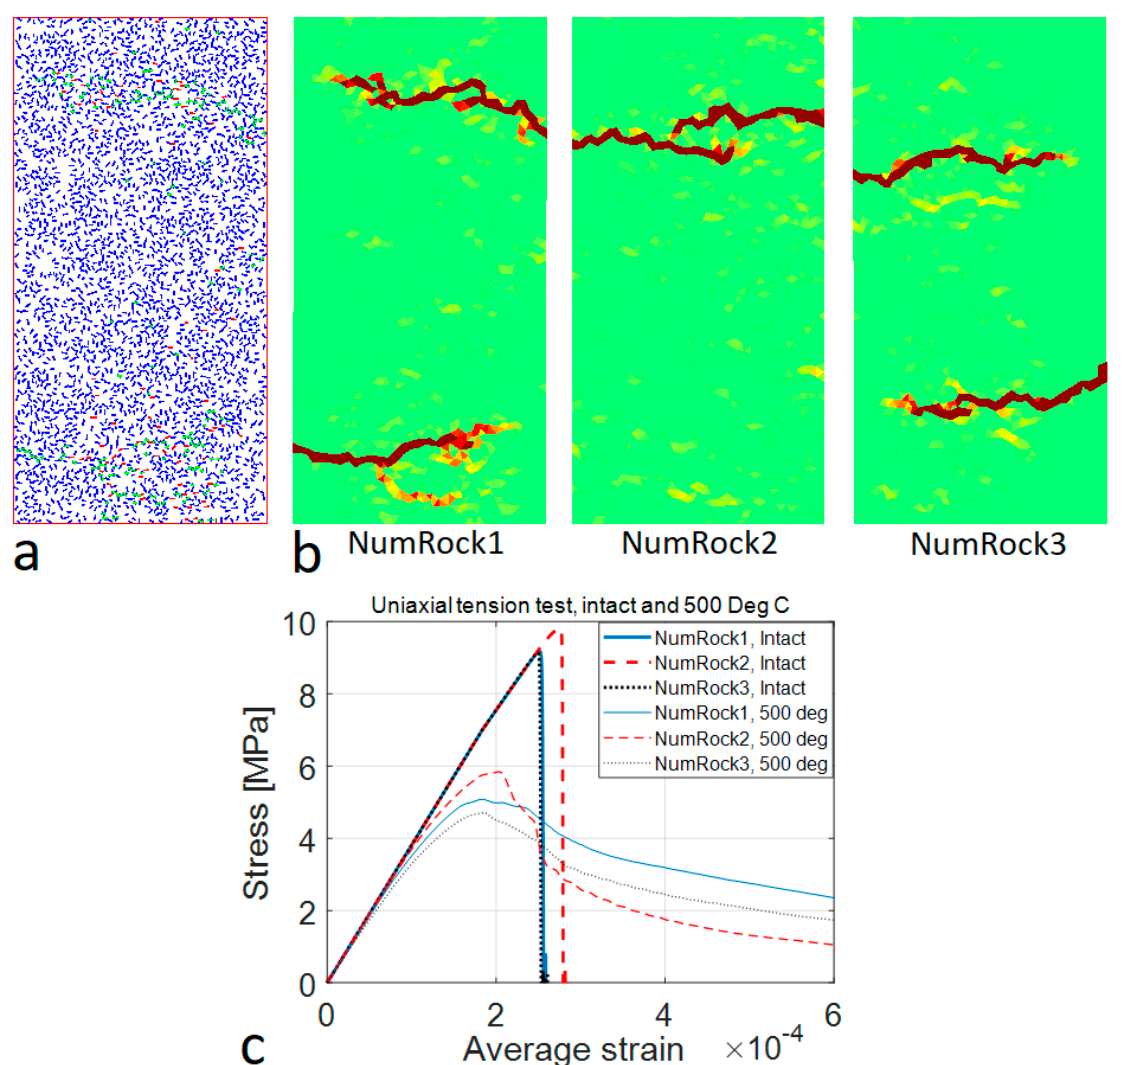
Figure 8. Simulation results for uniaxial tension test (heat treated rock, 500 ° C): ( a ) cracks with NumRock1; ( b ) failure modes represented by crack opening magnitude; ( c ) average stress–strain curves.